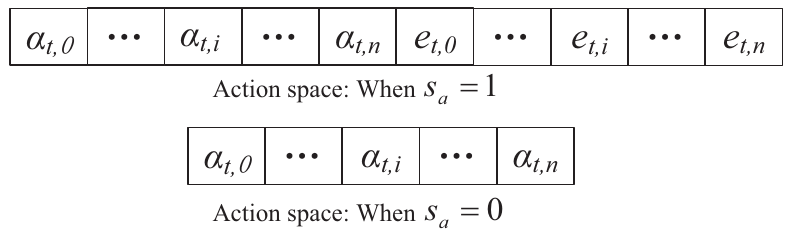
Figure 5. The action space